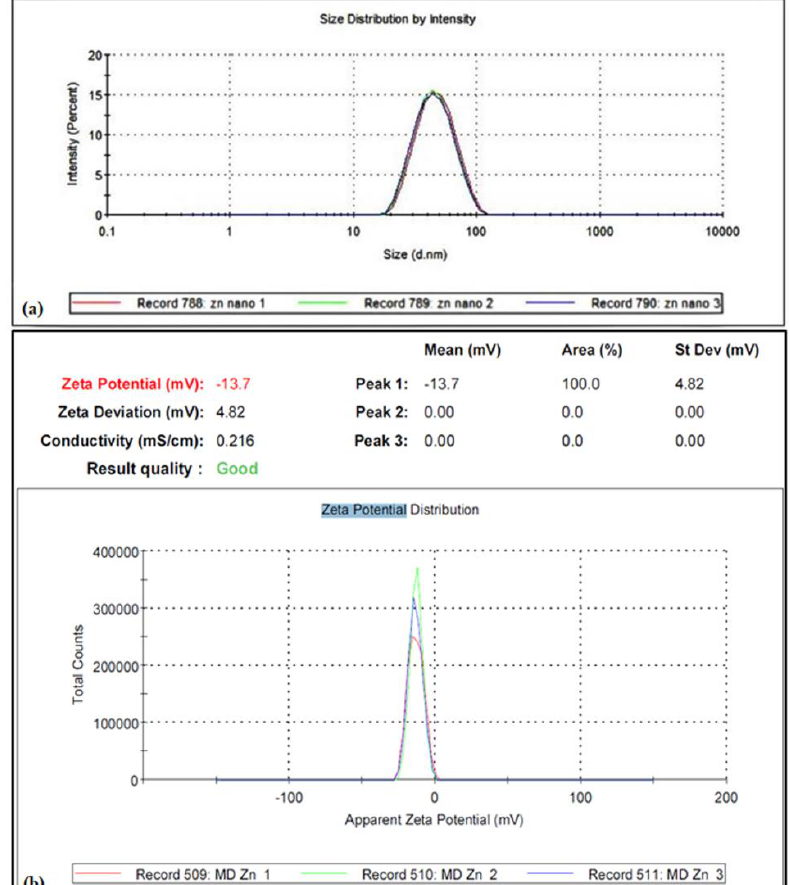
Figure 2. UV − Vis absorption spectra of synthesized ZnO NPs ( a ), ZnO NPs image under transmis- sion electron microscope (TEM) ( b ), FTIR spectrum ( c ), X-ray diffraction (XRD) pattern ( d ), and EDX spectrum ( e ) of the synthesized ZnO NPs.